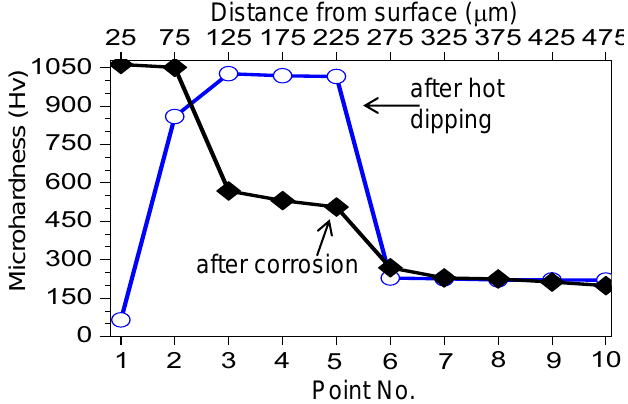
Figure 5. Microhardness variation along the depth of the Al hot-dipped carbon steel before and after heating at 800 °C for 100 h in N 2 /0.1% H 2 S gas.